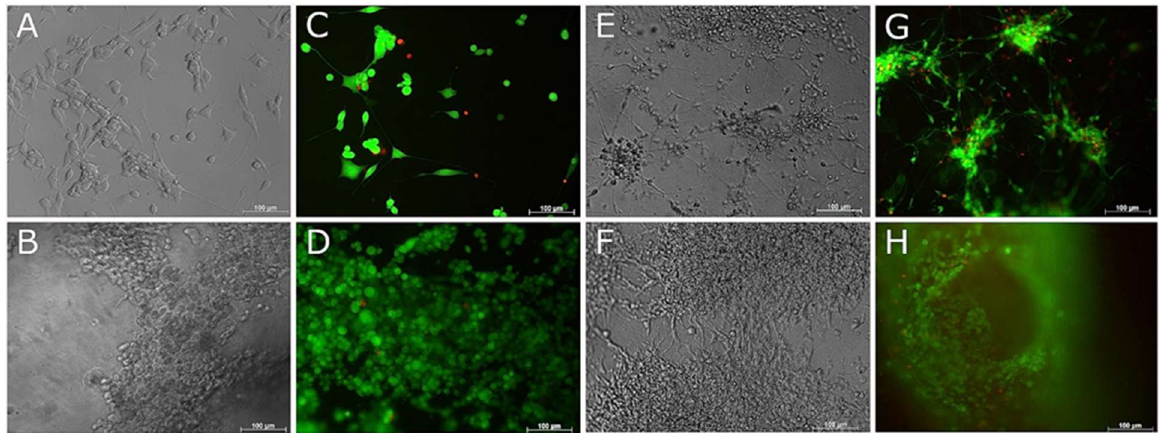
Figure 6. Live and Dead and phase contrast images of NSC-34 and RenCell VM neural progenitor cells surface seeded to 2.5/mL fish collagen. Phase contrast ( A , B , E , F ) and live and dead ( C , D , G , H ) images taken of NSC-34 ( A – D ) and RenCell VM ( E – H ) at day 7. Top and bottom rows correspond to cells cultured with differentiation media and growth media, respectively. Scale bars represent 100 µm.